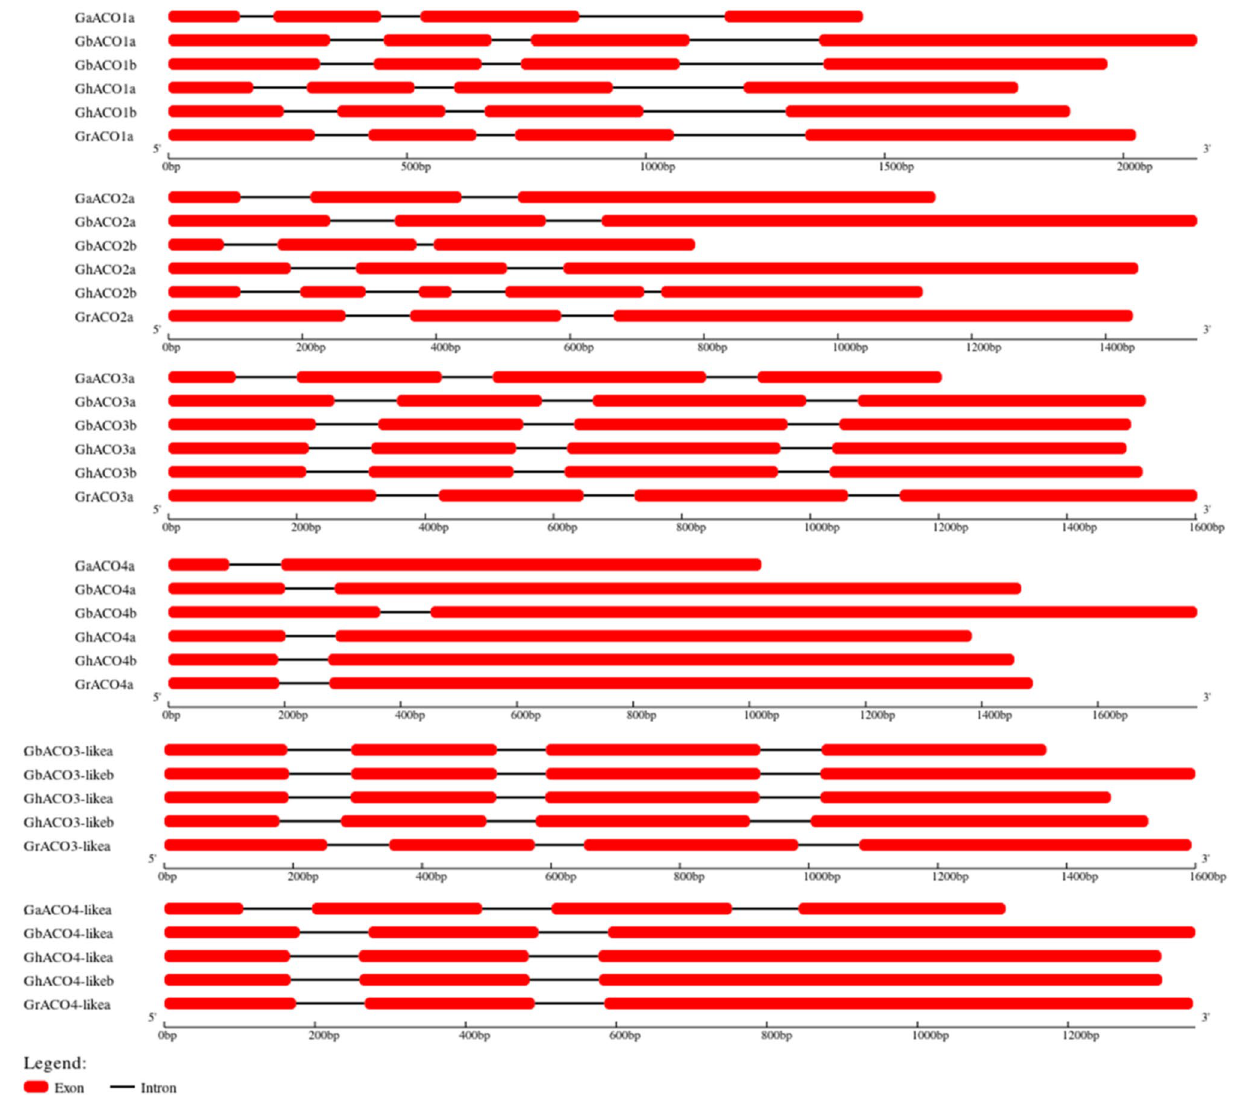
Figure 2. Gene structure of ACO isoforms showing intronic and exonic